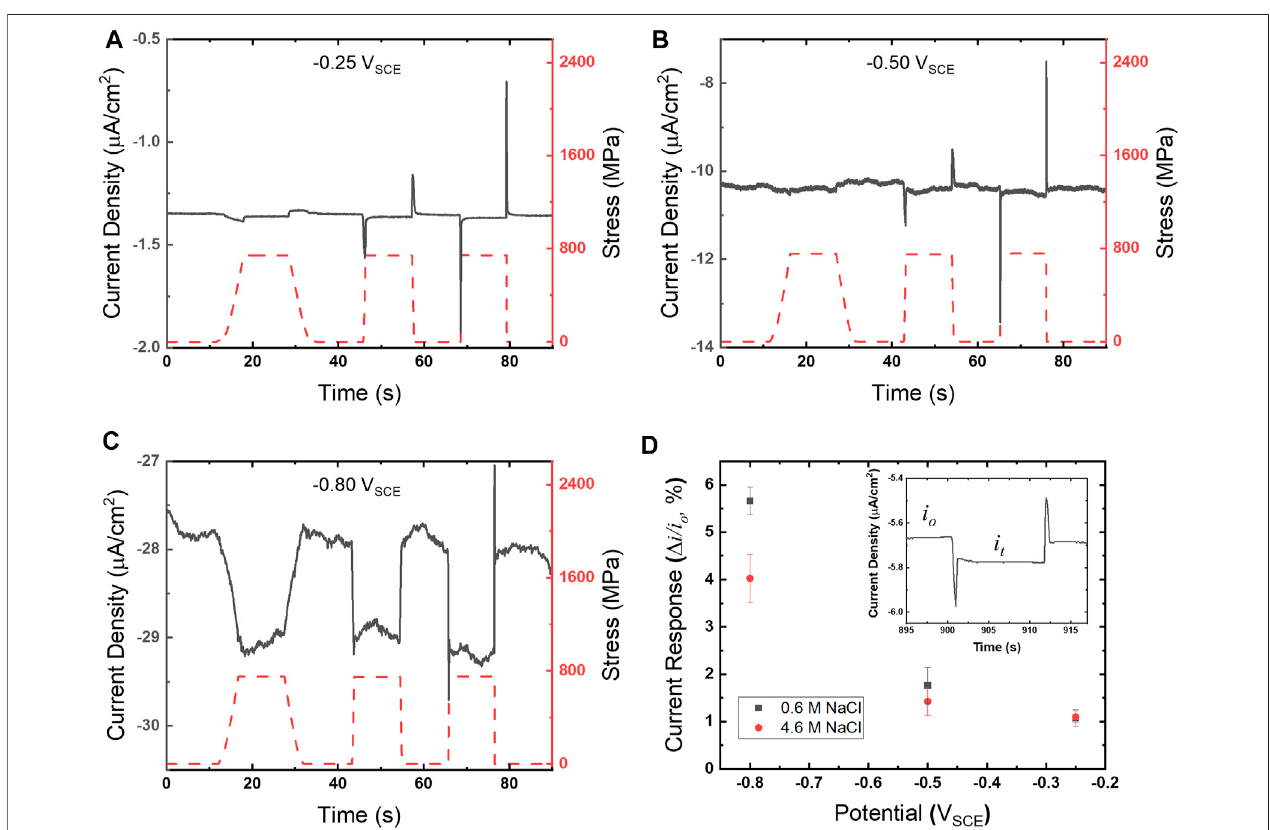
FIGURE 3 | Chronoamperograms (gray solid line, left ordinate) and corresponding stress pro fi les (red dashed line, right ordinate) for UNS S13800 with 25 μ l of 4.6 M NaCl at 25 ° C and 80% RH for (A) − 0.25 V SCE , (B) − 0.50 V SCE and (C) − 0.80 V SCE . Strain rates for (A – C) follow a sequence of 0.0002, 0.002 and 0.02/s. The current responses for 4.6 and 0.6 M NaCl determined from Eq. 1 are shown in (D) as a function of